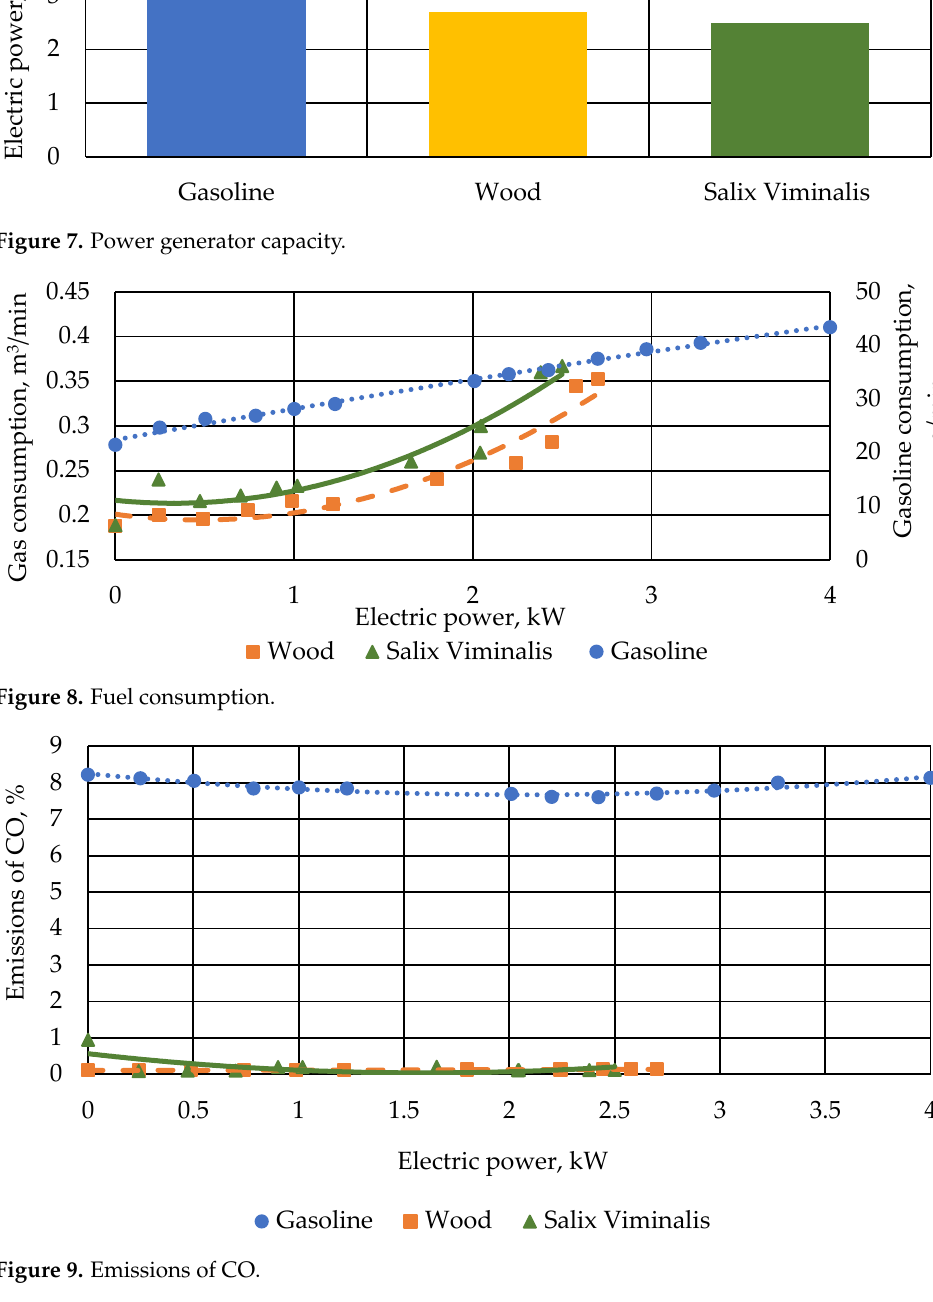
Figure 7. Power generator capacity.